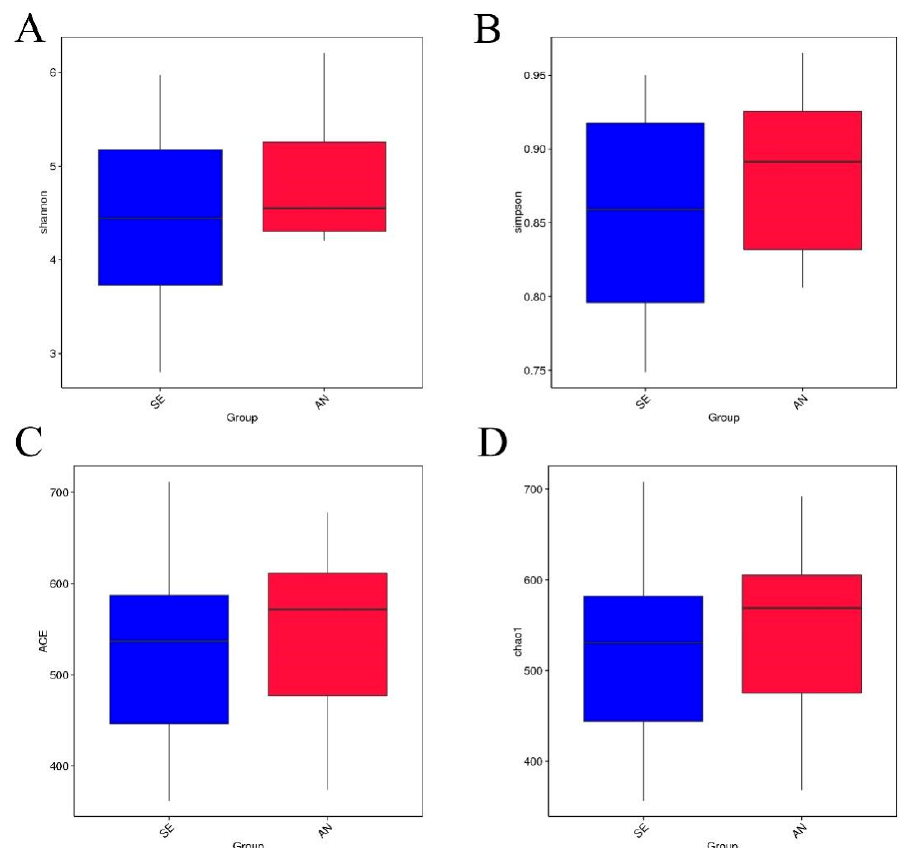
Figure 5. Comparison of alpha diversity indices of the bacterial communities in AN (red) and SE (blue) samples. ( A ) Comparison of the Shannon index. ( B ) Comparison of the Simpson index. ( C ) Comparison of the Chao1 index. ( D ) Comparison of the ACE index.